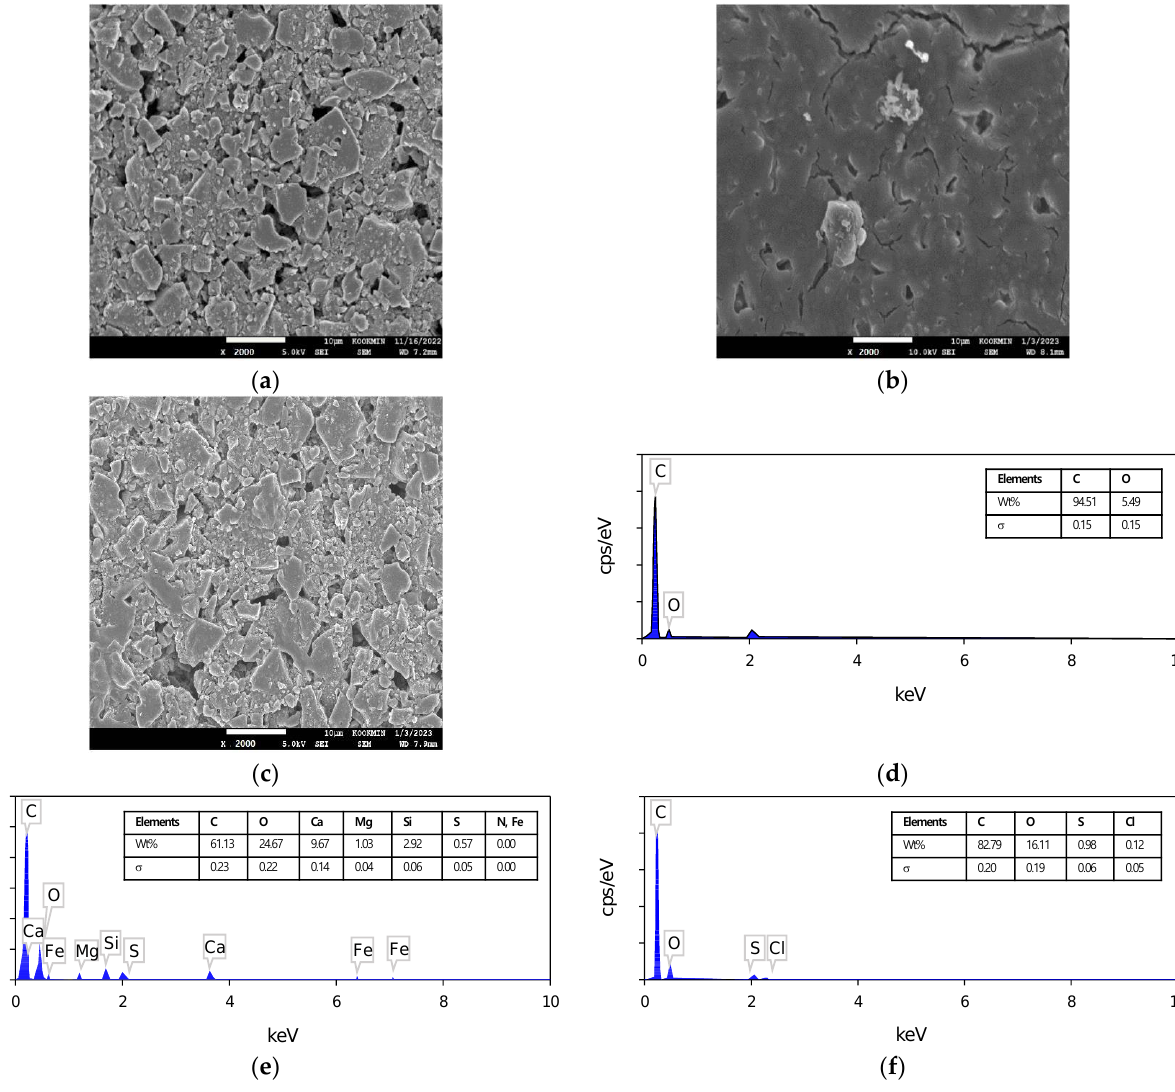
Figure 11. FE-SEM images and EDS spectrum of electrodes surface before and after use: ( a ) virgin electrodes for different times; ( b ) cathode fouled by Ca, Si, and Mg; ( c ) anode fouled by S and Cl at 2000 times, respectively; ( d – f ) show the EDS spectra of ( a – c ), respectively.